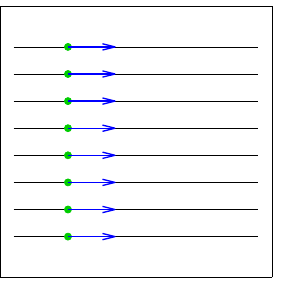
Figure 12. Parallel flow.